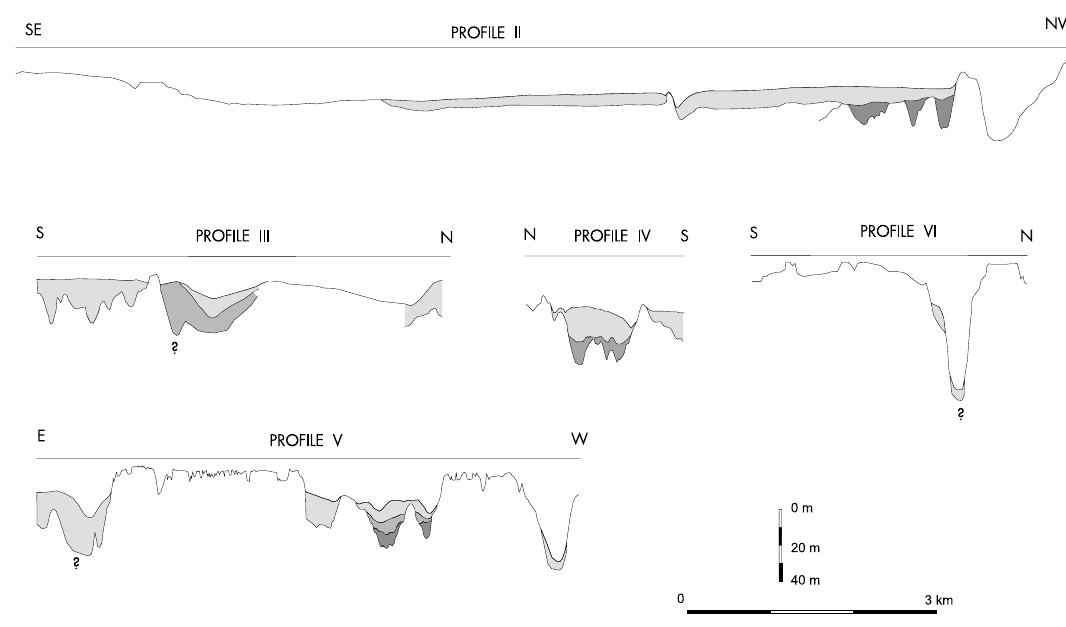
Fig. 10 – Interpretation of the seismic profiles with possible sedimentary